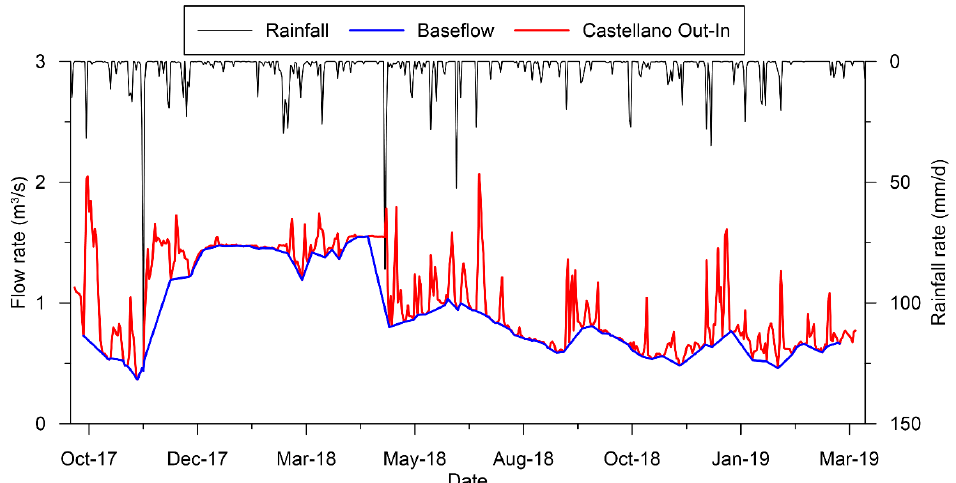
Figure 6. Flow rate difference between the two instrumented sections of the Castellano stretch (upstream and downstream hydrographic stations in Figure 2) and the calculated BFI stream baseflow. Rainfall for the same period is also shown.